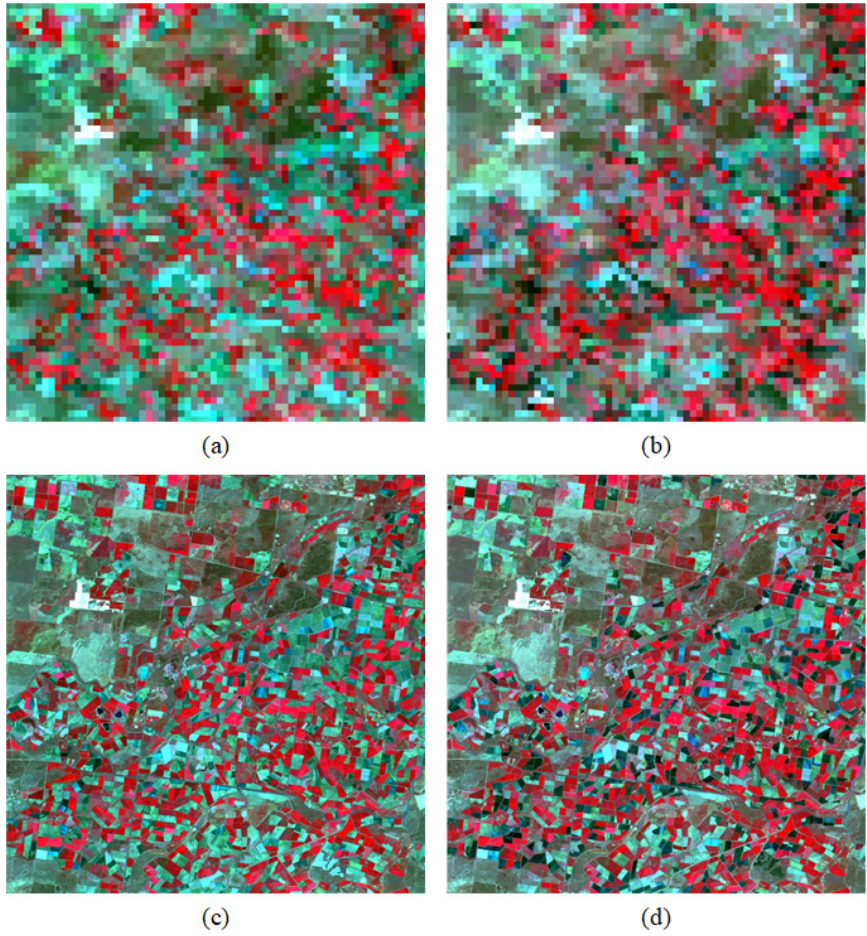
Figure 4. Composite MODIS ( Top row ) and Landsat ( Bottom row ) image pairs on 7 October ( a , c ) and 16 October ( b , d ) 2001 on the CIA [44] dataset. The CIA dataset focuses on noteworthy phenological changes in irrigated farmland.